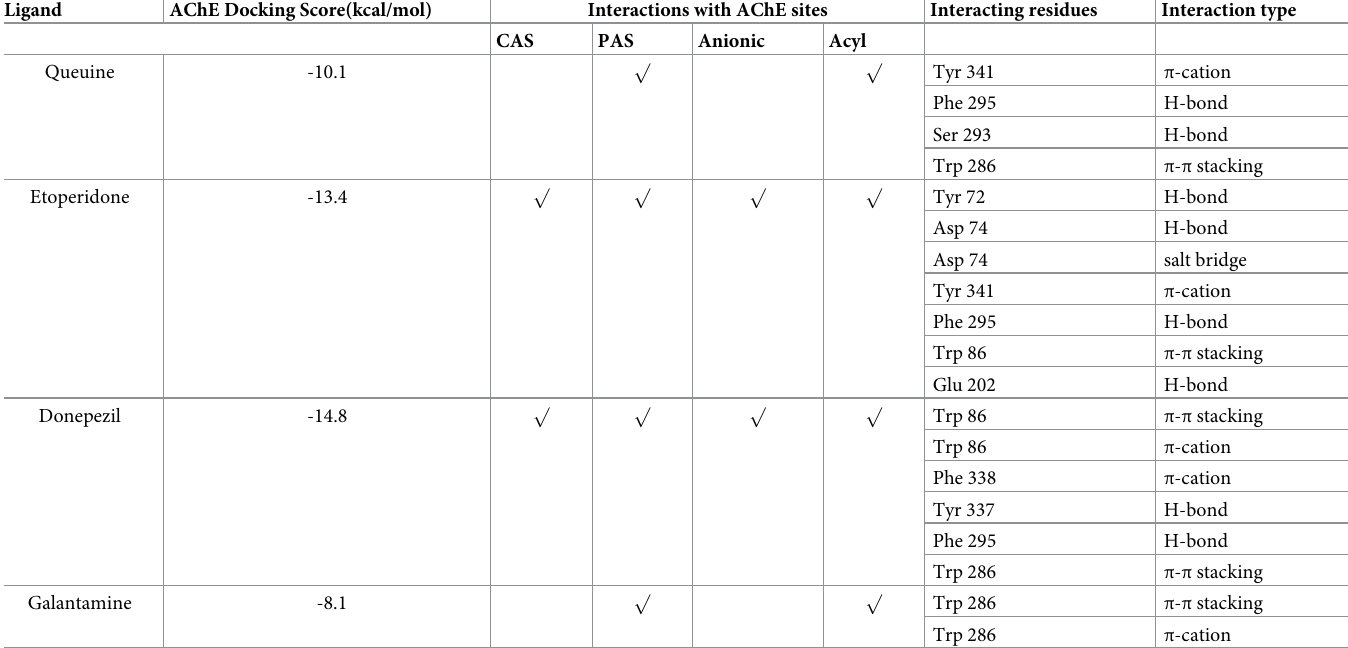
Table 2. Docking analysis of proposed natural compounds as compared with control molecules: Docking scores, interaction sites and residues involved in AChE binding site. Ligand AChE Docking Score(kcal/mol)